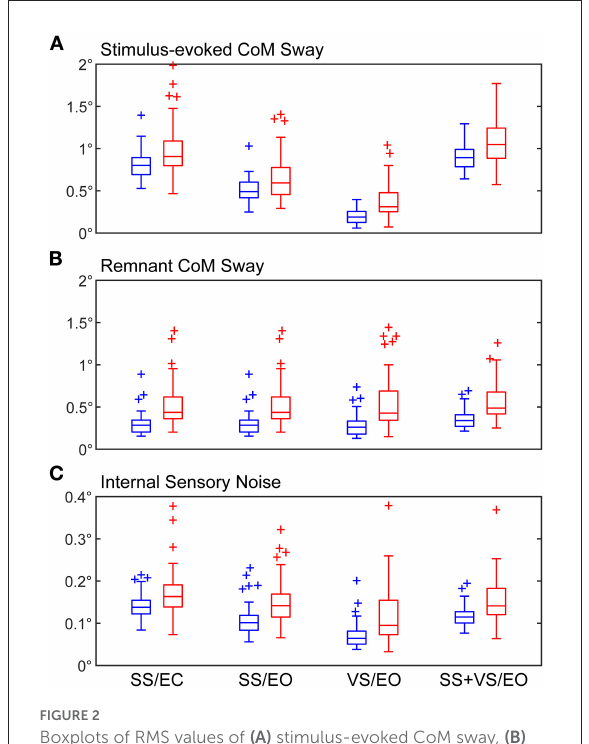
FIGURE2 Boxplots of RMS values of (A) stimulus-evoked CoM sway, (B) remnant CoM sway, and (C) internal sensory noise. Results are shown for both healthy control (blue) and mTBI (red) subjects for the four CSMI test conditions. Central box shows median (center line) with upper and lower quartiles defined by 0.75 quantile and 0.25 quantile values, respectively. Outliers ( + ) are defined as values that are > 1.5 times the interquartile range. Whiskers extend to maximum and minimum values that are not considered